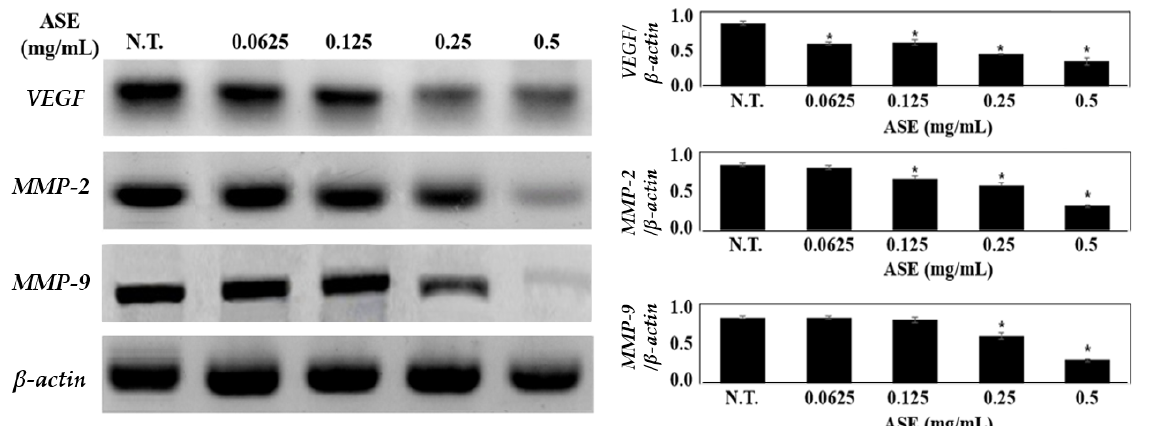
Figure 3. The effect of ASE on expressions of VEGF , MMP-2 , and MMP-9 mRNA. MMP-2 and MMP-9 which are members of the MMP family and implicated in cancer cell migration, invasion, and metastasis in various cancers. VEGF is a major angiogenic growth gene found in cancer cells. β - actin was used as an internal control. Each result in the graph is presented as the mean ± standard deviation based on band intensity for each group ( n = 3). Values are statistically significant at * p < 0.05 vs. respective control group.